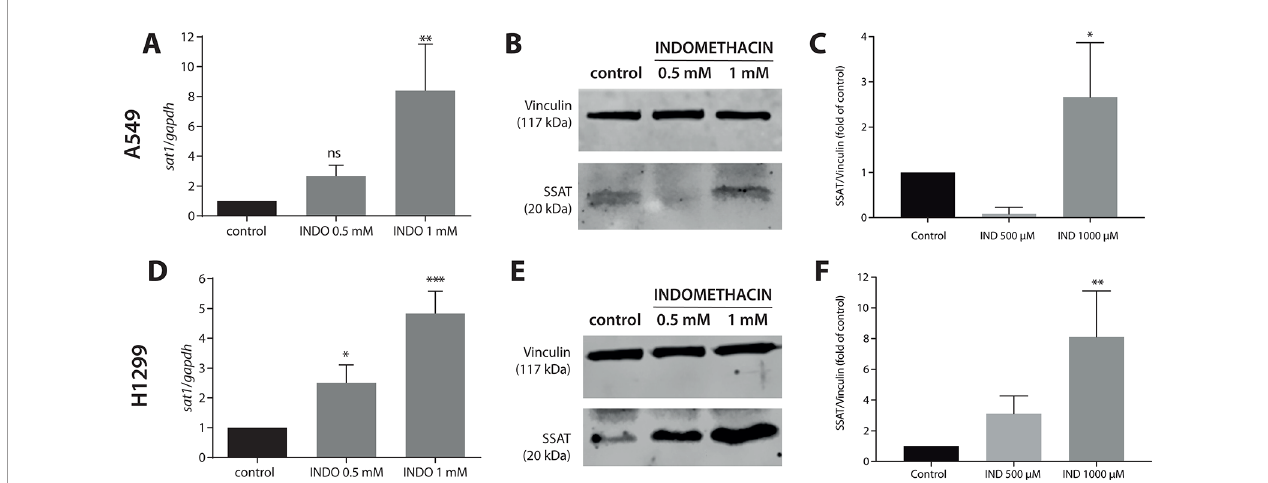
FIGURE 1 | Effect of indomethacin on the expression of SAT1 and levels of spermidine/spermine-N 1 -acetyltransferase (SSAT) in non-small cell lung cancer (NSCLC) cells. A549 and H1299 cells were exposed to indomethacin 0.5 and 1 mM for 24 h. The messenger RNA (mRNA) levels of SAT1 and protein levels of SSAT were evaluated using quantitative PCR (qPCR) and western blotting, respectively. (A) The mRNA levels of SAT1 in A549 cells. (B) Representative blot of the SSAT protein levels in A549 cells exposed to indomethacin. (C) Quantitation of the SSAT levels in A549 cells exposed to indomethacin. (D) The mRNA levels of SAT1 in H1299 cells. (E) Representative blot of the SSAT levels in H1299 cells exposed to indomethacin. (F) Quantitation of the SSAT levels in H1299 cells exposed to indomethacin. * p < 0.05; ** p < 0.01, *** p < 0.0001 and ns, no signi fi cant compared with untreated control, calculated using one-way ANOVA and Dunnett ’ s post- test. Data summarize the results of three independent